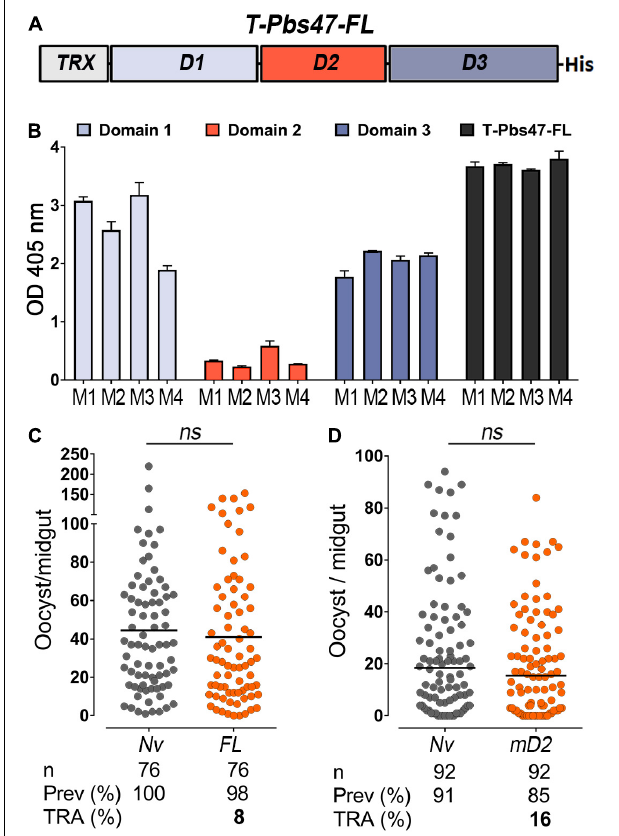
FIGURE 1 | Immunoreactivity and transmission-reducing activity of total sera against modified T-Pbs47-FL and Pbs47-mD2. (A) Schematic representation of Plasmodium berghei T-Pbs47-FL fusion protein. Domains 1, 2, and 3 are represented to scale; His denotes a six-Histidine tag, “T” denotes Thioredoxin. (B) ELISA reactivity of sera from four mice immunized with T-Pbs47-FL against Pbs47 domains 1, 2, and 3; column and errors bars represent mean OD 405 ± standard deviation of two replicate assays. (C) TRA of T-Pbs47-FL and (D) Pbs47-mD2 following direct mosquito feeding on individual mouse. Each dot represents the number of oocysts in individual mosquito and the lines indicate the medians per group. Number of mosquitoes dissected (n); Infection prevalence (Prev); Transmission-reducing activity (TRA) as percent inhibition of infection intensity relative to naïve control mice. These data represent the overall result from n = 4 mice feeding. Medians were compared using the Mann–Whitney test: ns, no significant difference.